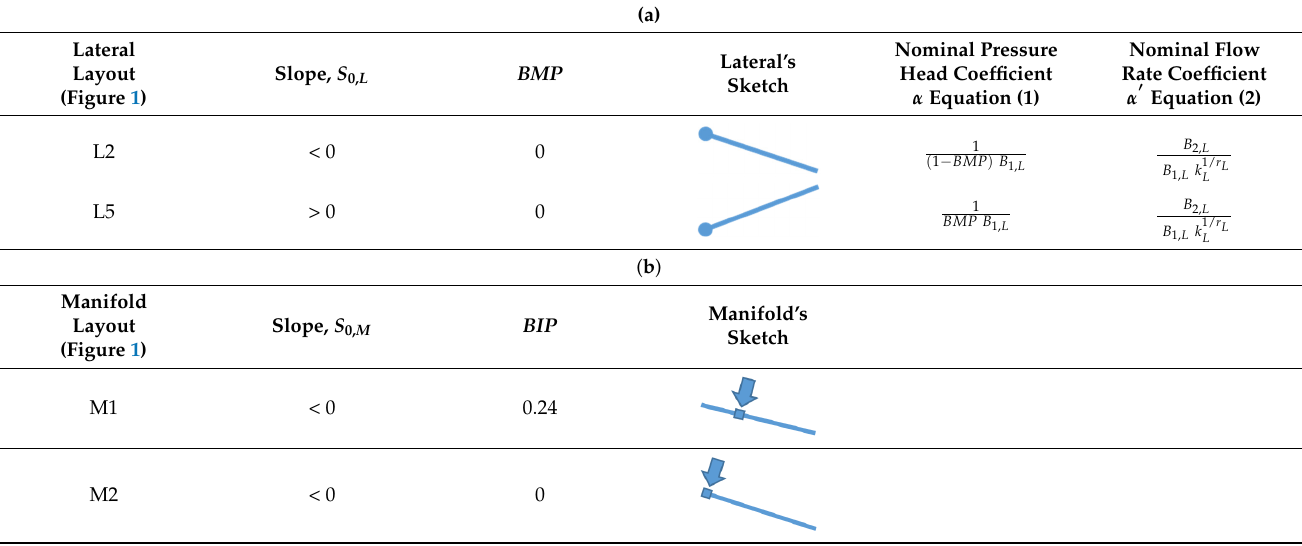
1a,b, respectively (rearranged by Baiamonte [28]). Therefore, as can be seen in these tables, designing each sector by IRRILAB and detecting the corresponding layout requires BMP , slopes to be established ( S 0, L , S 0, M ). manifold slopes to be established ( S 0, L , S 0, M ). Table 1. ( a ) Lateral’s sketch of the considered lateral layouts L2 and L5, and corresponding coefficients of the nominal emitters’ pressure head and flow rate design relationships, α and α (cid:48) , as a function of the calibration constants mentioned in Table 1. ( a ) Lateral’s sketch of the considered lateral layouts L2 and L5, and corresponding coefficients of the nominal Table 1. ( a ) Lateral’s sketch of the considered lateral layouts L2 and L5, and corresponding coefficients of the nominal emitters’ pressure head and flow rate design relationships, α and α ′, as a function of the calibration constants mentioned Table 2. Rearranged with permission from ref. [29], Copyright 2020, Elsevier (Amsterdam, The Netherlands); ( b ) Manifold’s emitters’ pressure head and flow rate design relationships, α and α ′ , as a function of the calibration constants mentioned in Table 2. Rearranged with permission from ref. [29], Copyright 2020, Elsevier (Amsterdam, The Netherlands); ( b ) Man- Table 1. ( a ) Lateral’s sketch of the considered lateral layouts L2 and L5, and corresponding coefficients of the nominal sketch, of the considered manifold layouts M1 and M2. Rearranged with permission from ref. [29], Copyright 2020, Elsevier in Table 2. Rearranged with permission from ref. [29], Copyright 2020, Elsevier (Amsterdam, The Netherlands); ( b ) Man- Table 1. ( a ) Lateral’s sketch of the considered lateral layouts L2 and L5, and corresponding coefficients of the nominal ifold’s sketch, of the considered manifold layouts M1 and M2. Rearranged with permission from ref. [29], Copyright 2020, emitters’ pressure head and flow rate design relationships, α and α ′ , as a function of the calibration constants mentioned (Amsterdam, The Netherlands). ifold’s sketch, of the considered manifold layouts M1 and M2. Rearranged with permission from ref. [29], Copyright 2020, emitters’ pressure head and flow rate design relationships, α and α ′ , as a function of the calibration constants mentioned Elsevier (Amsterdam, The Netherlands). in Table 2. Rearranged with permission from ref. [29], Copyright 2020, Elsevier (Amsterdam, The Netherlands); ( b ) Man- Elsevier (Amsterdam, The Netherlands). in Table 2. Rearranged with permission from ref. [29], Copyright 2020, Elsevier (Amsterdam, The Netherlands); ( b ) Man- ifold’s sketch, of the considered manifold layouts M1 and M2. Rearranged with permission from ref. [29], Copyright 2020, ifold’s sketch, of the considered manifold layouts M1 and M2. Rearranged with permission from ref. [29], Copyright 2020, Elsevier (Amsterdam, The Netherlands). Elsevier (Amsterdam, The